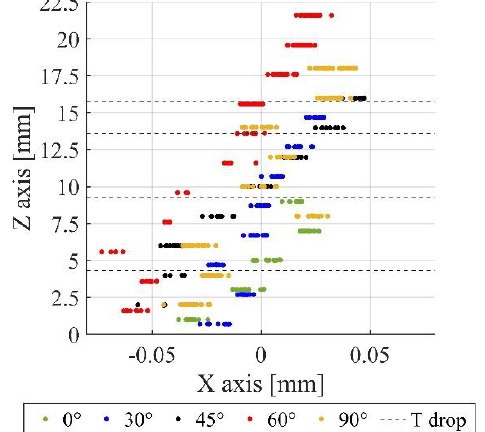
Figure 10. Points measured on datum plane B on each geometry: the dashed lines represent the layer corresponding to the temperature drops that occurred during the printing procedure. Figure 10 confirms the layer-shifting upon increasing the Z coordinate in all